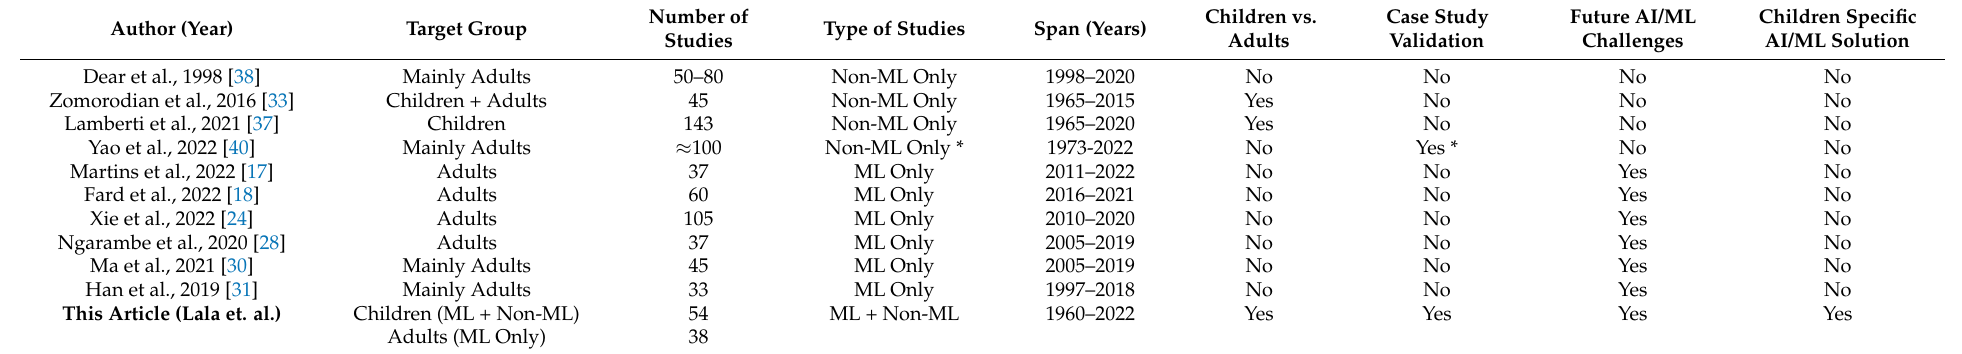
Table 1. Comparative analysis of this review article with recent literature